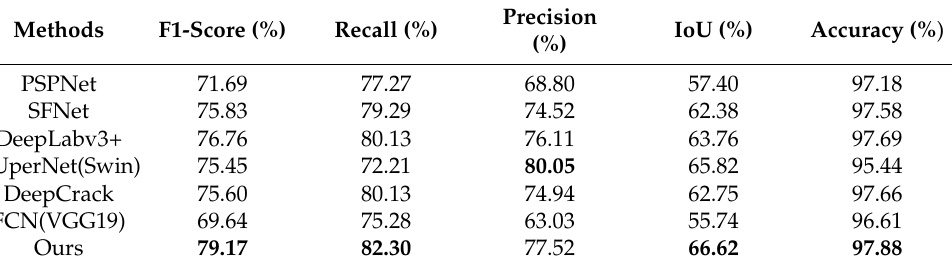
Table 4. Comparison with state-of-the-art deep learning models on the Crack500 test